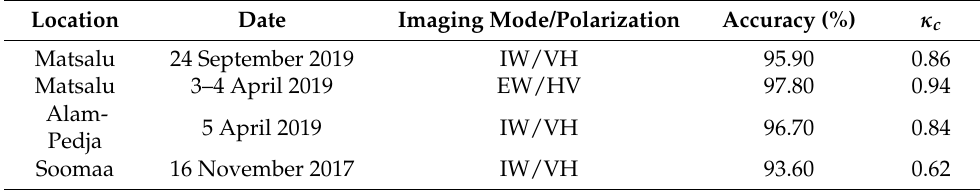
Table 6. Validation results. Accuracy and κ c values for different test sites and imaging